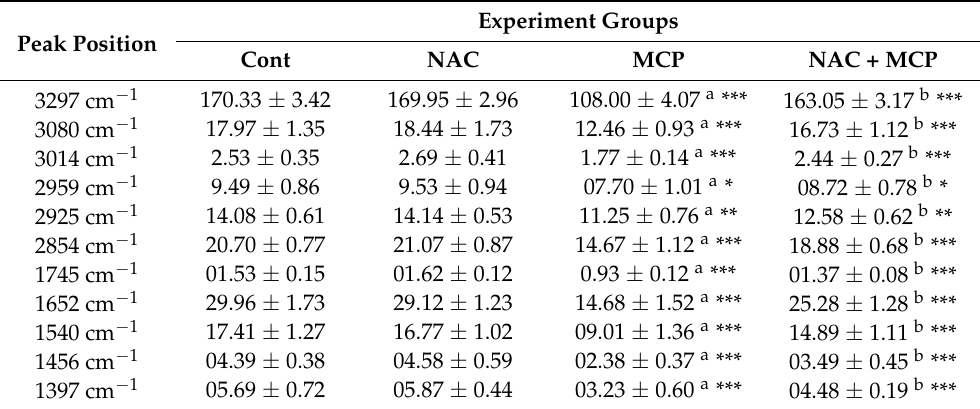
Table 4. Effect of NAC pretreatment on peak area values of FTIR spectra in hepatic tissue of rat exposed to MCP.